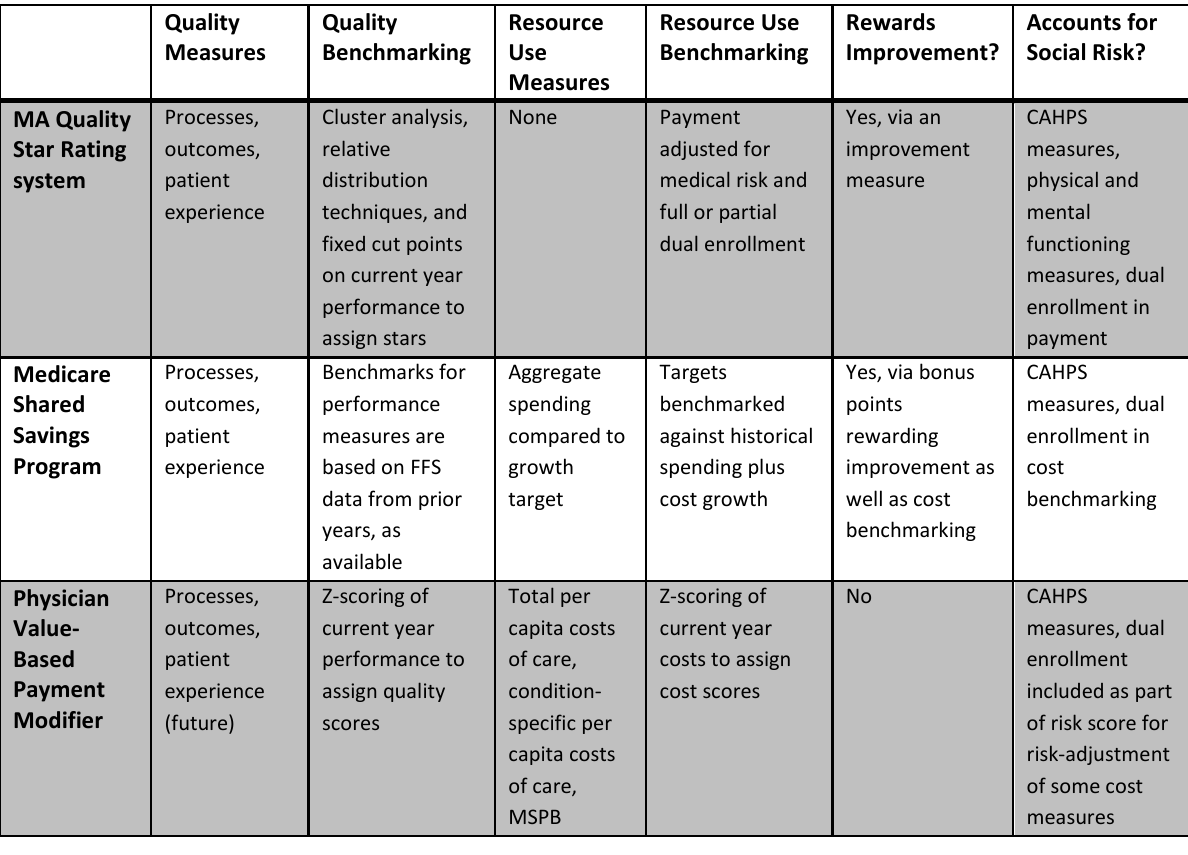
Table S3.1: Comparison of Quality and Cost Methodology in MA, the Medicare Shared Savings Program, and Physician